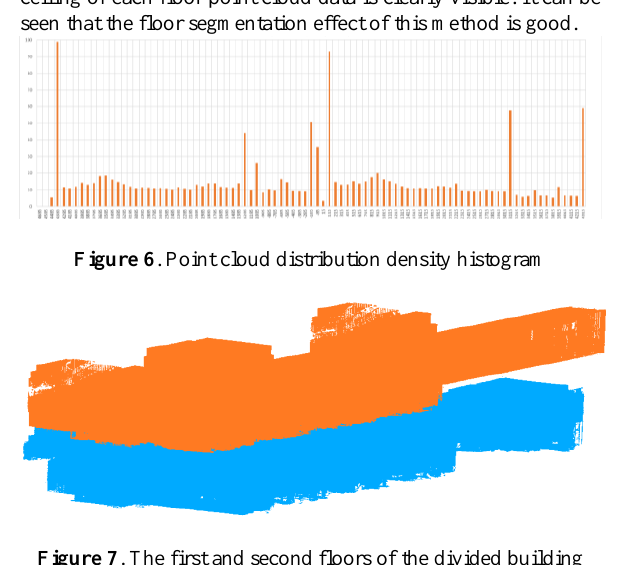
Figure 7 . The first and second floors of the divided building